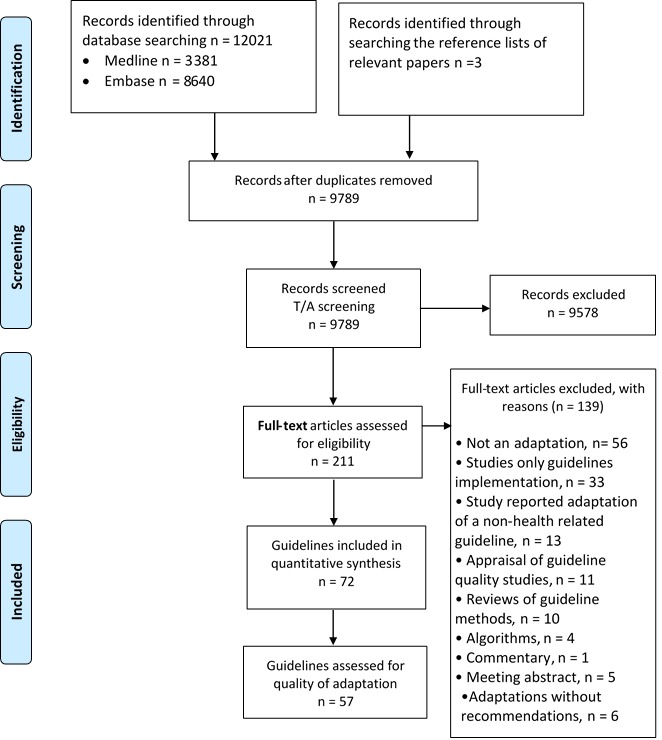
Study flow diagram.